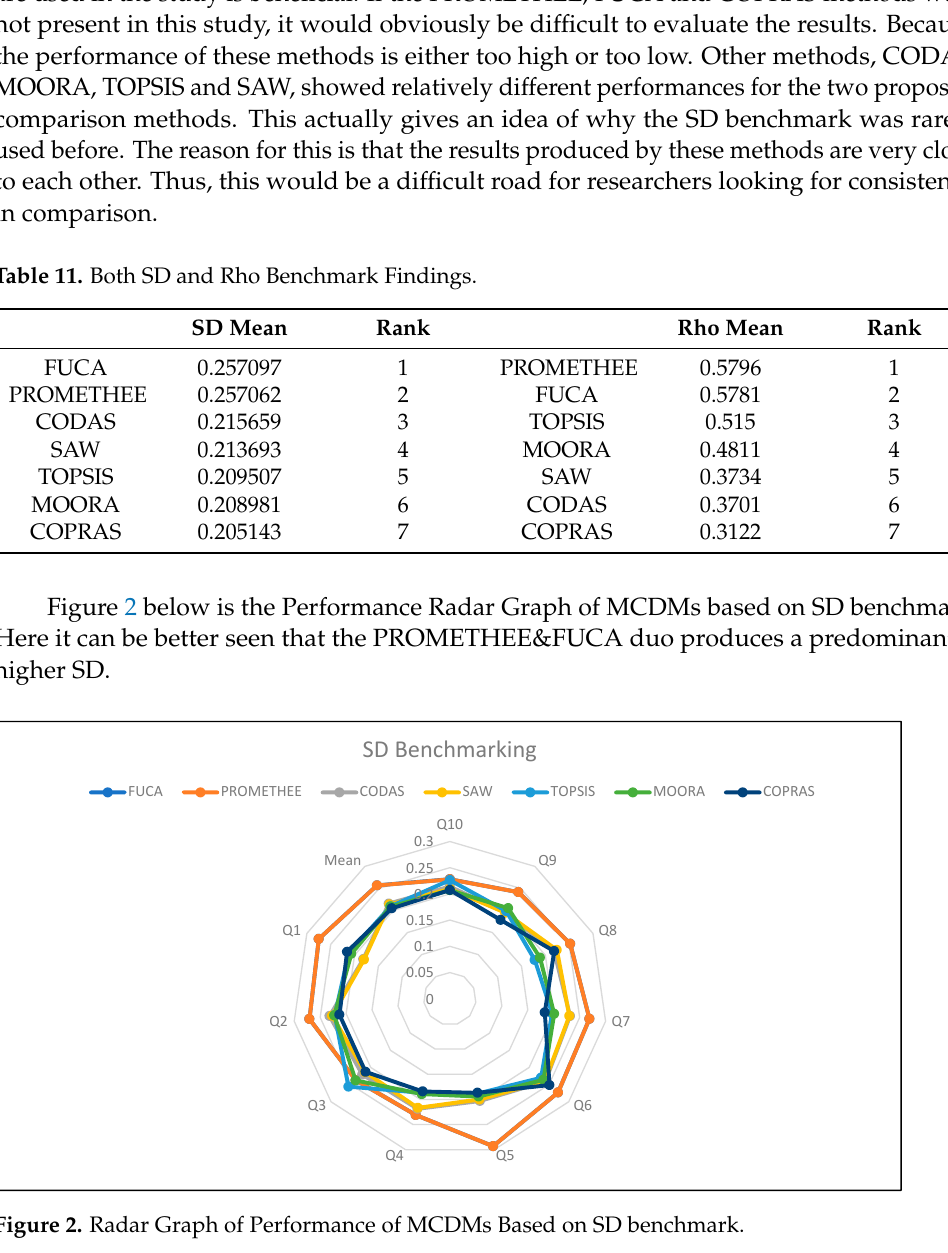
Table 11. Both SD and Rho Benchmark Findings.